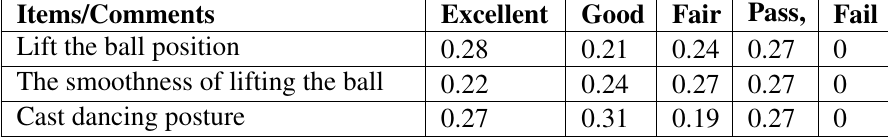
Table 5 Score of student 2 evaluated in the